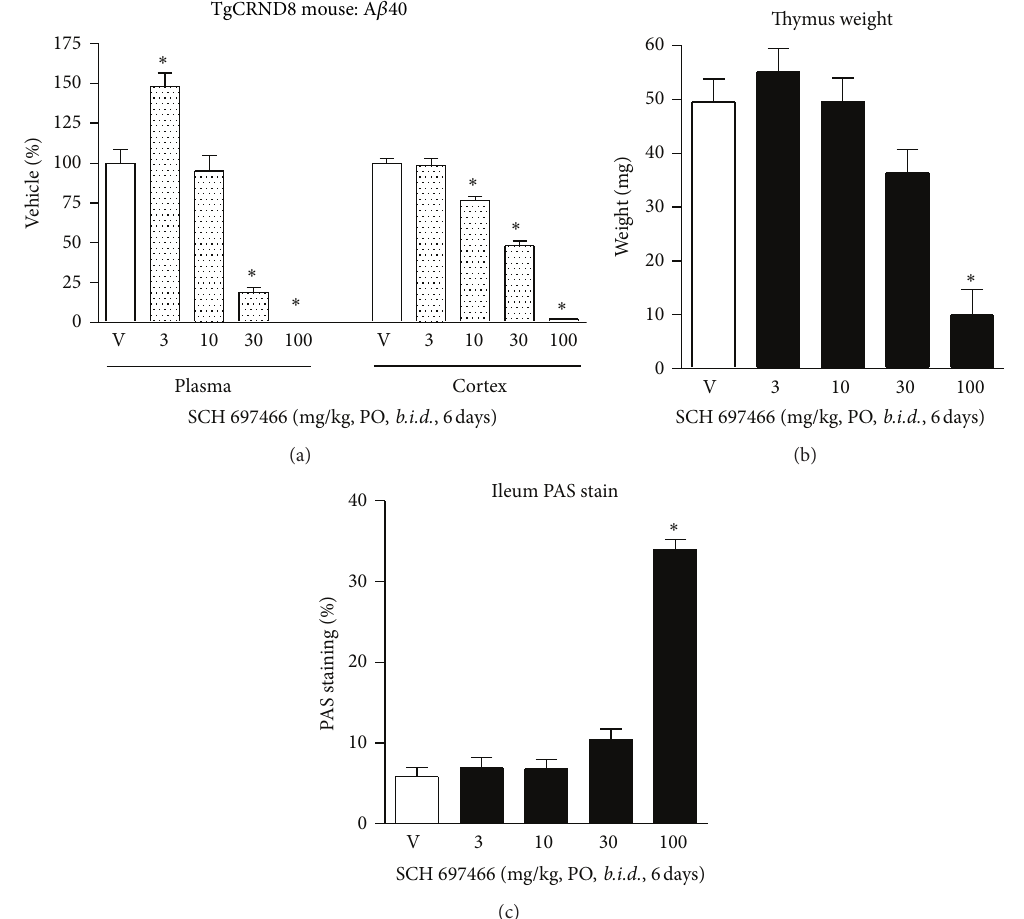
Figure 4: (a) A 𝛽 40 levels expressed as a percent of vehicle in plasma and cortex, (b) thymus weight, and (c) percent area in the ileum covered by PAS stain following 6 days of b.i.d. administration of SCH 697466 to TgCRND8 mice. The final dose of SCH 697466 was given on day